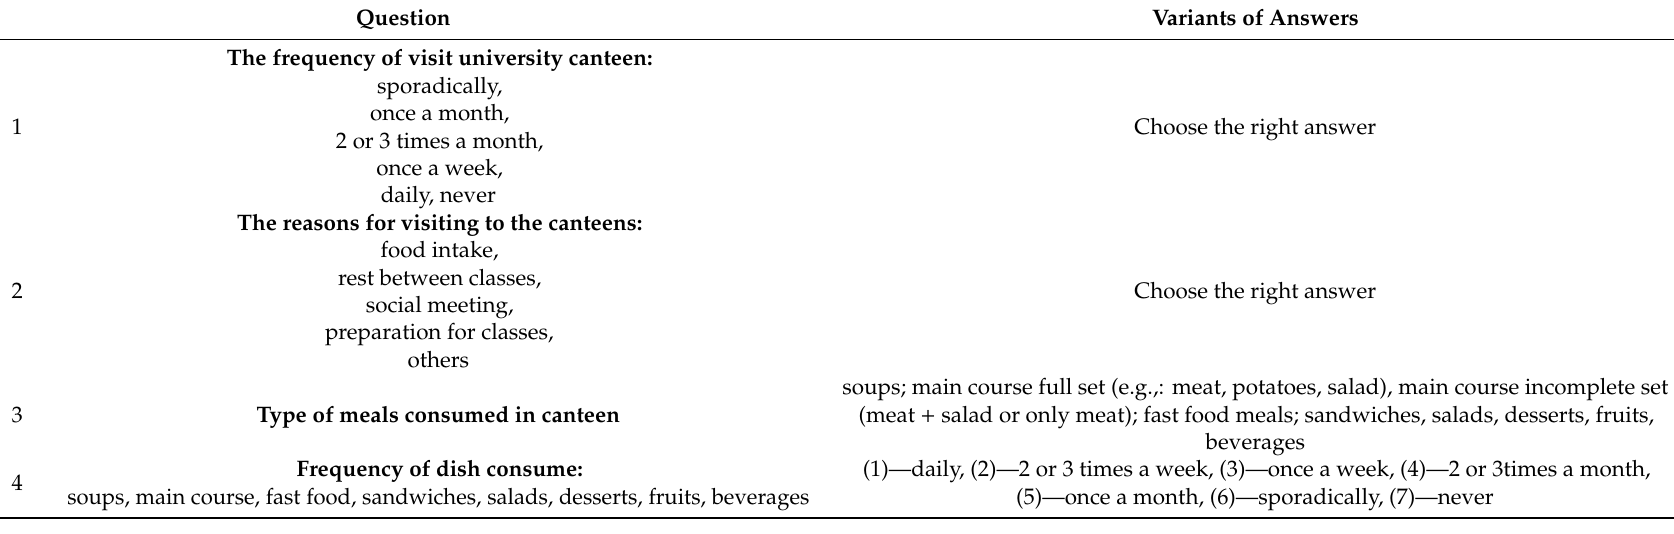
Table 1. Questionnaire